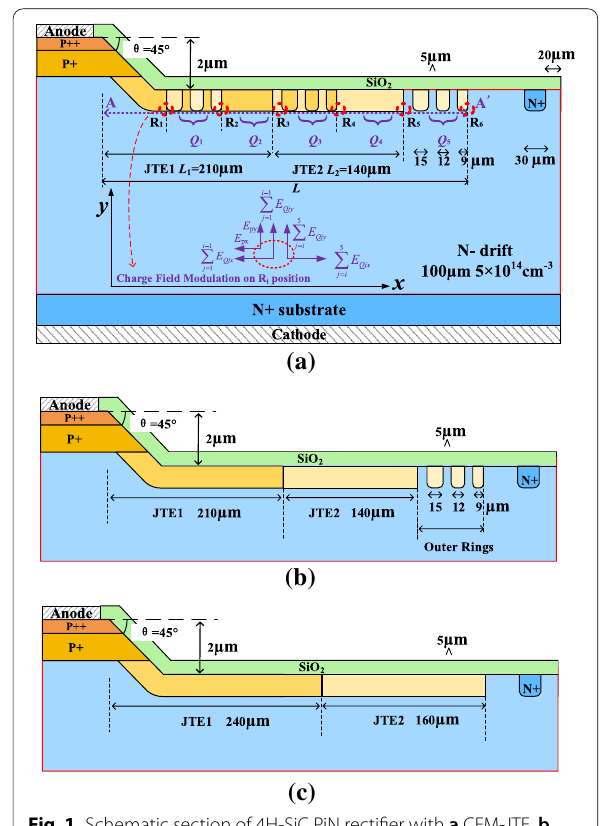
Fig. 1 Schematic section of 4H‑SiC PiN rectifier with a CFM‑JTE, b ORA‑JTE, c conventional